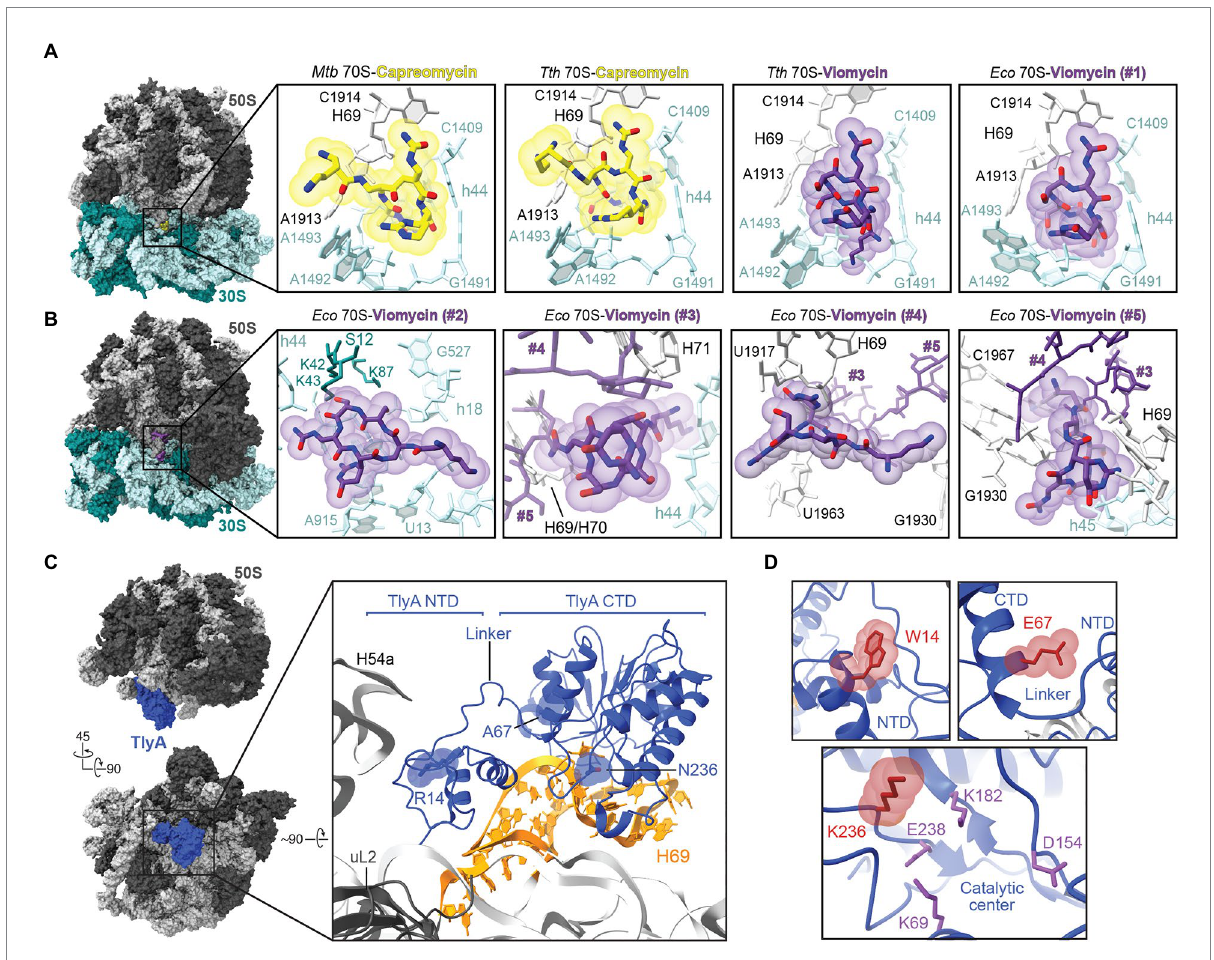
FIGURE 2 Molecular basis of tuberactinomycin action and resistance. (A) Overview of the Mycobacterium tuberculosis (Mtb) 70S structure (PDB code 5 V93) with the capreomycin (yellow) binding site indicated within the boxed region. Zoomed-in views are also shown of the primary tuberactinomycin antibiotic binding site at the 30S and 50S interface for ( left to right ): capreomycin bound to the M. tuberculosis 70S (PDB code 5 V93) and T. thermophilus ( Tth ) 70S (PDB code 4V7M), and for viomycin (purple) bound to T. thermophilus 70S (PDB code 4V7L) and E. coli ( Eco ) 70S (PDB code 6LKQ). For ease of comparison, nucleotides are labeled with E. coli numbering where shown. (B) Overview of the E. coli 70S-viomycin complex and zoomed-in views of the four additional viomycin binding sites, #2 to #5, identified in this structure (PDB code 6LKQ). Note that viomycin molecules at sites #3-#5 make interactions with each other and are shown in each view but with only the focused viomycin shown with atom coloring. (C) Two views of the structure of the mycobacterial 50S subunit-TlyA complex ( left ). In the top view, the 50S subunit is shown in the same orientation as in the 70S ribosome views of panels A and B . Also highlighted in the zoomed-in view are TlyA (blue), its rRNA binding site on H69, and three amino acid substitutions leading to loss of TlyA activity from missense tlyA mutations in M tuberculosis clinical isolates. (D) Zoomed-in views of the sites of amino acid substitution shown with the residue arising from clinical resistance mutation